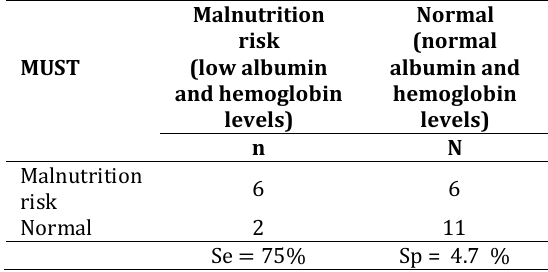
Table 3. The result of the test validity (specificity and sensitivity) on the use of Nutritional Risk Screening (NRS-2002) in relation to metabolic